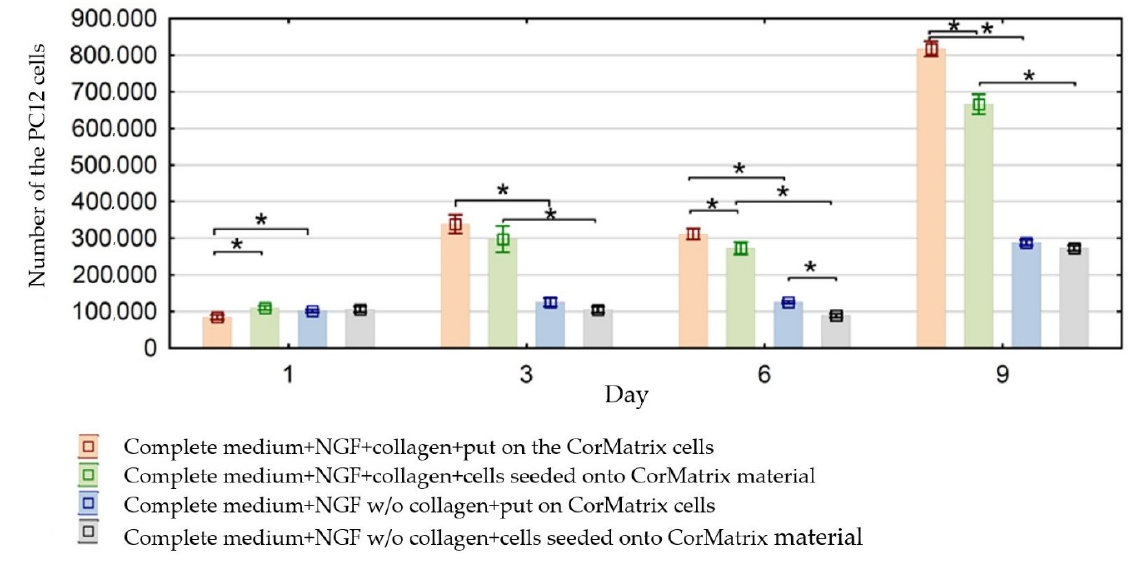
Figure 2. Number of cells in the collected medium (cell cultures with CorMatrix material); * p < 0.05—significant difference in number of cells.